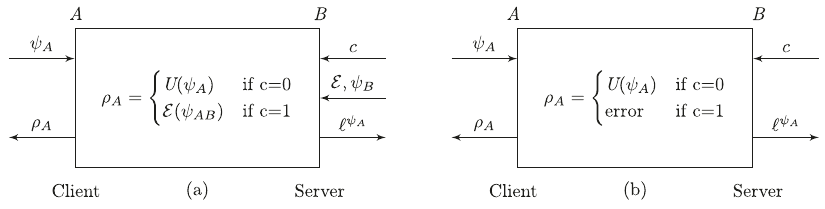
Fig. 4 DQC ideal resources with blindness and DQC ideal resources with both blindness and veri fi ability. The fi ltered control bit c = 0/1 denotes the honest/dishonest behavior of the server. The fi ltered functionalities with the input ψ B ; E and output ℓ ψ A of resource ( a ), and the output ℓ ψ A of resource ( b ) are accessible only to the dishonest server with c ¼ 1